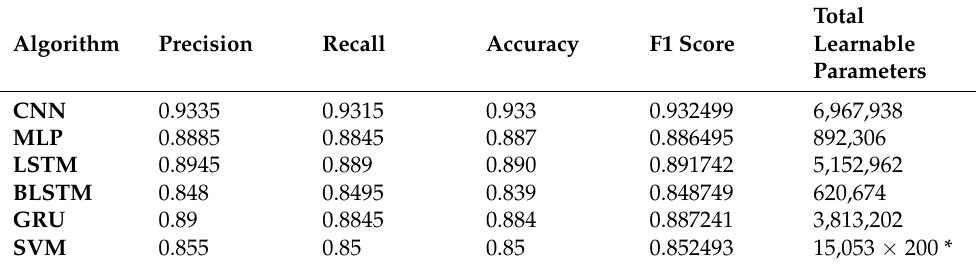
Table 5. Test Performance of the Final Tuned Gender